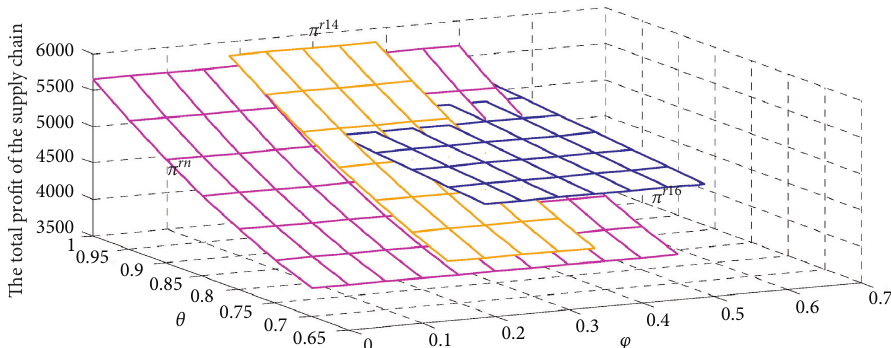
Figure 6: The total profit of the supply chain under linkage price cap